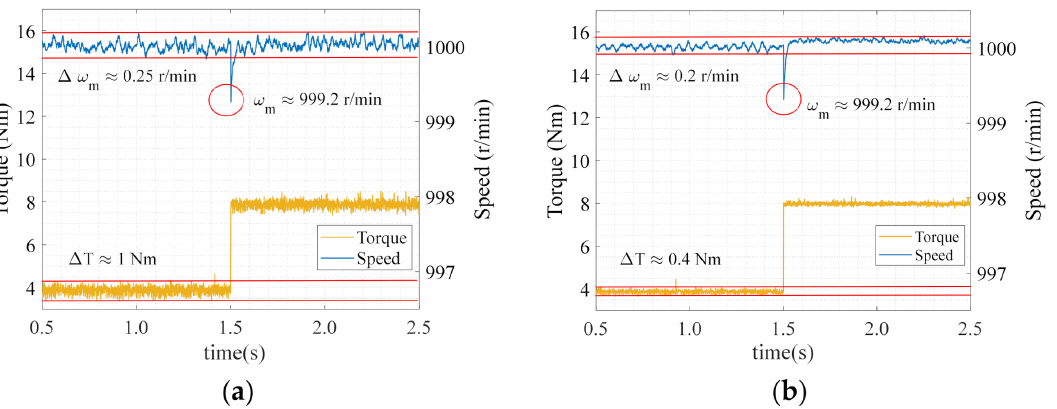
Figure 8. The torque and speed response: ( a ) SMC system with the FPRL; ( b ) SMC system with the